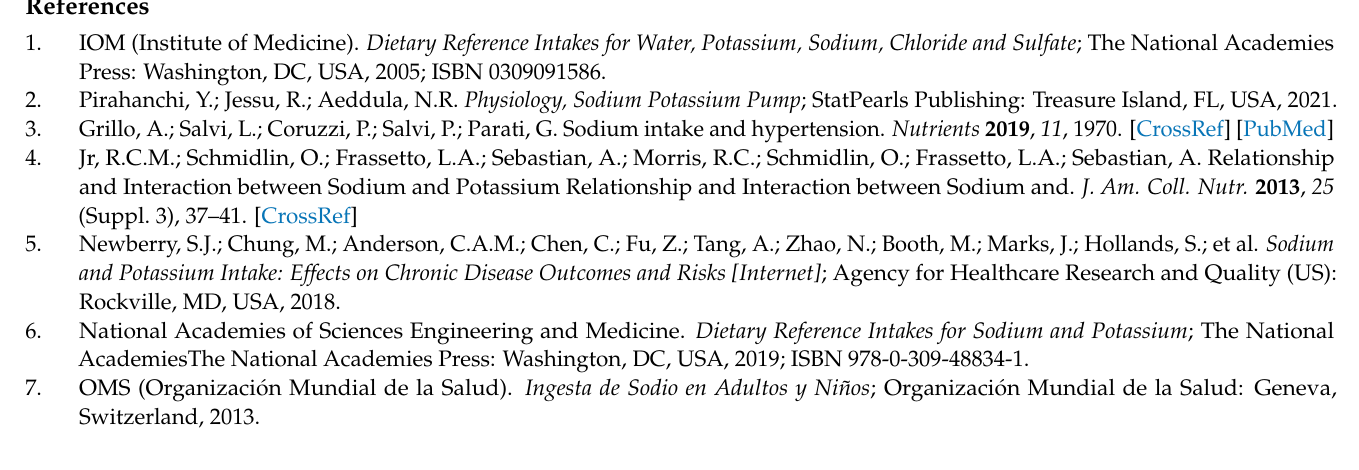
Table S2: Mean and contribution of sodium and potassium intake by Nova classification in Mexican population: ENSANUT 2016. Table S3: Mean intake and percentage contribution of sodium and potassium according to the Nova classification in the Mexican population: ENSANUT